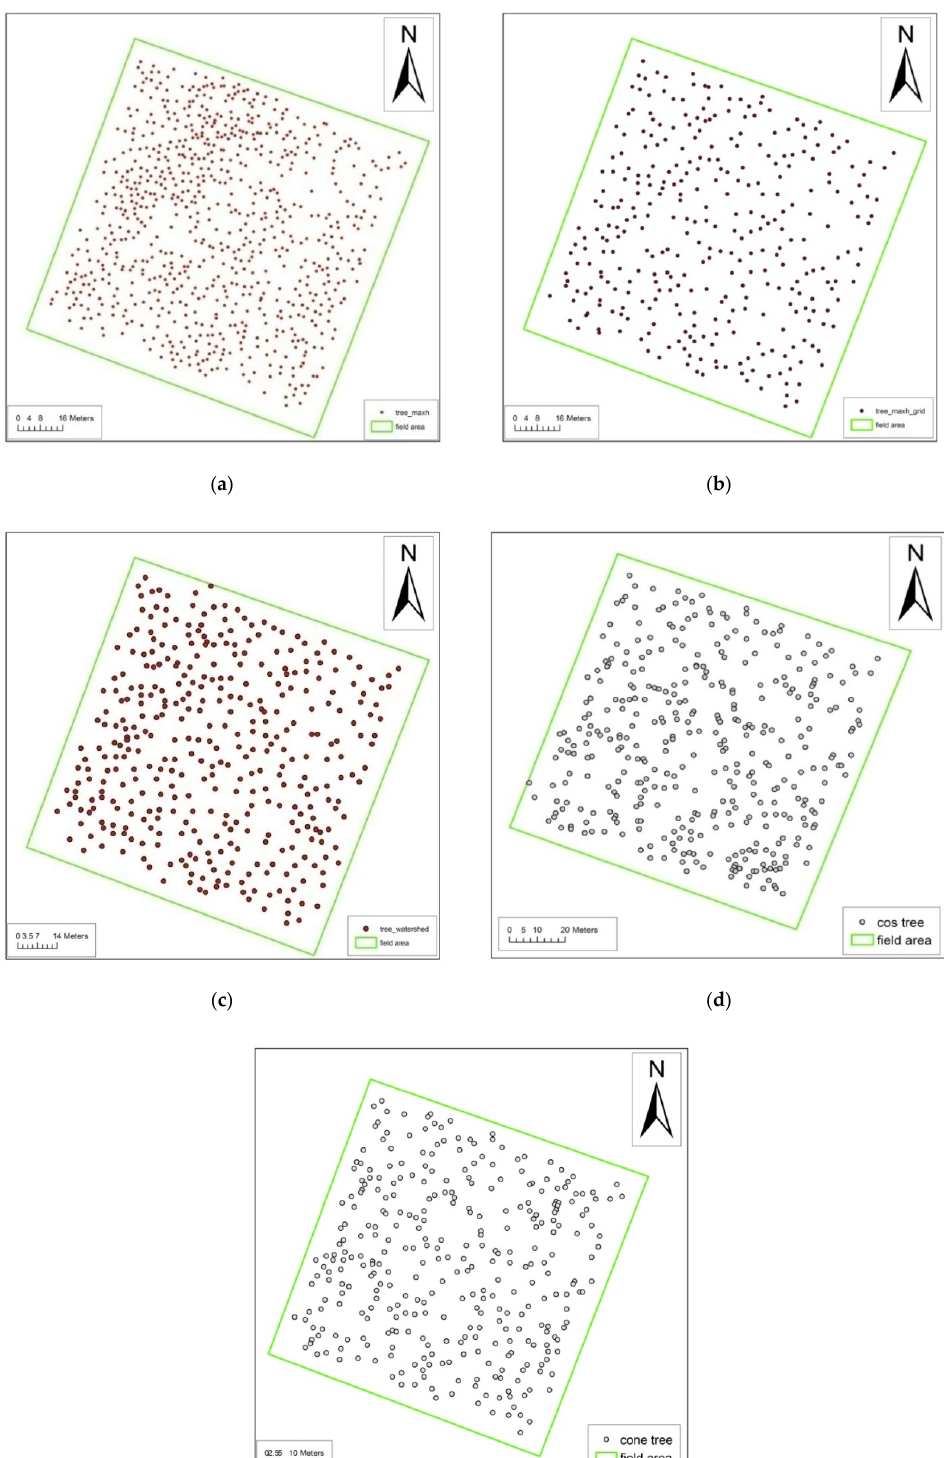
Figure 6. The distribution of the individual trees extracted by five different algorithms: ( a ) Max_H, ( b ) Max_CHM, ( c ) watershed, ( d ) cosine-template-matching, and ( e ) cone-template-matching